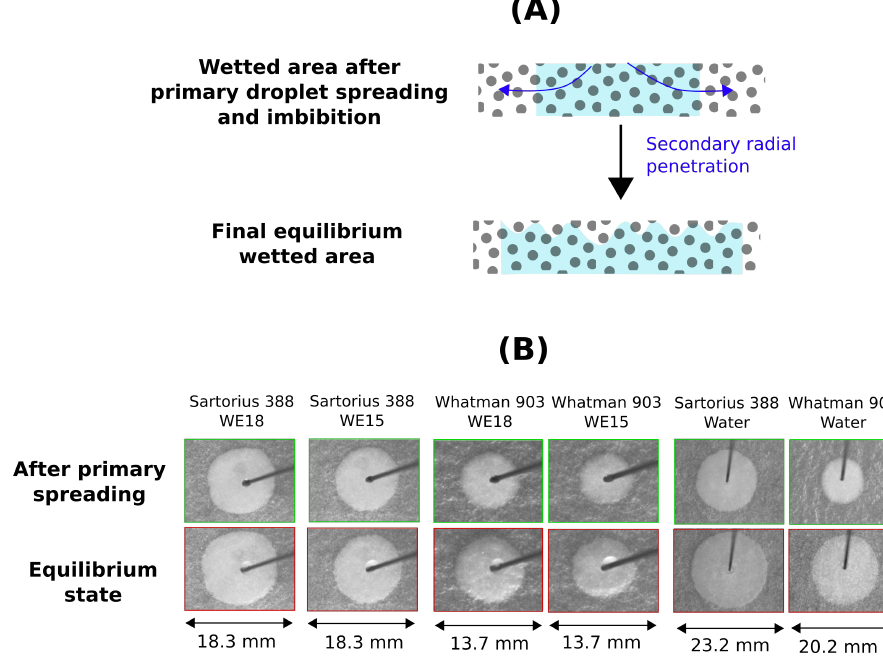
Figure 10. ( A ) Schematic representation of secondary radial liquid penetration, ( B ) Wetted areas observed right after the disappearance of the liquid cap and after equilibrium has been reached for different liquid-substrate combinations Table 1. Secondary radial penetration of water, WE18 and WE15 vesicle dispersions on Sartorius 388 and Whatman